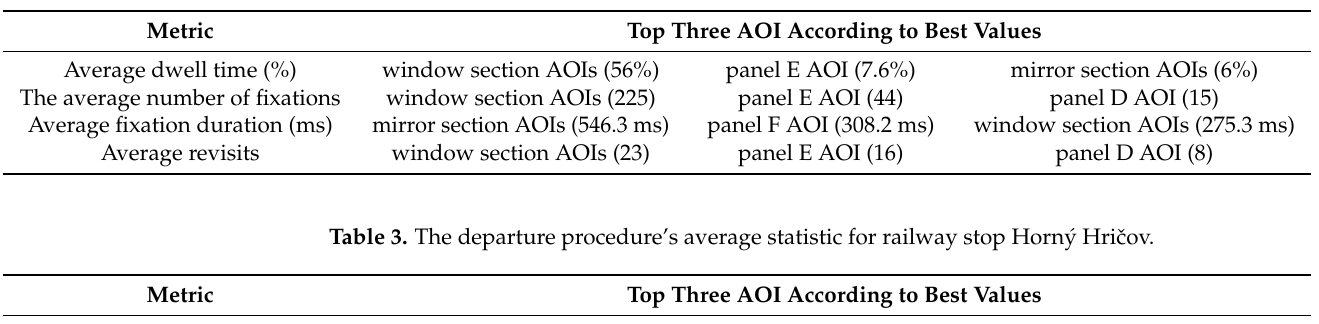
Table 2. The arrival procedure’s average statistic for railway stop Horn ý Hriˇcov.